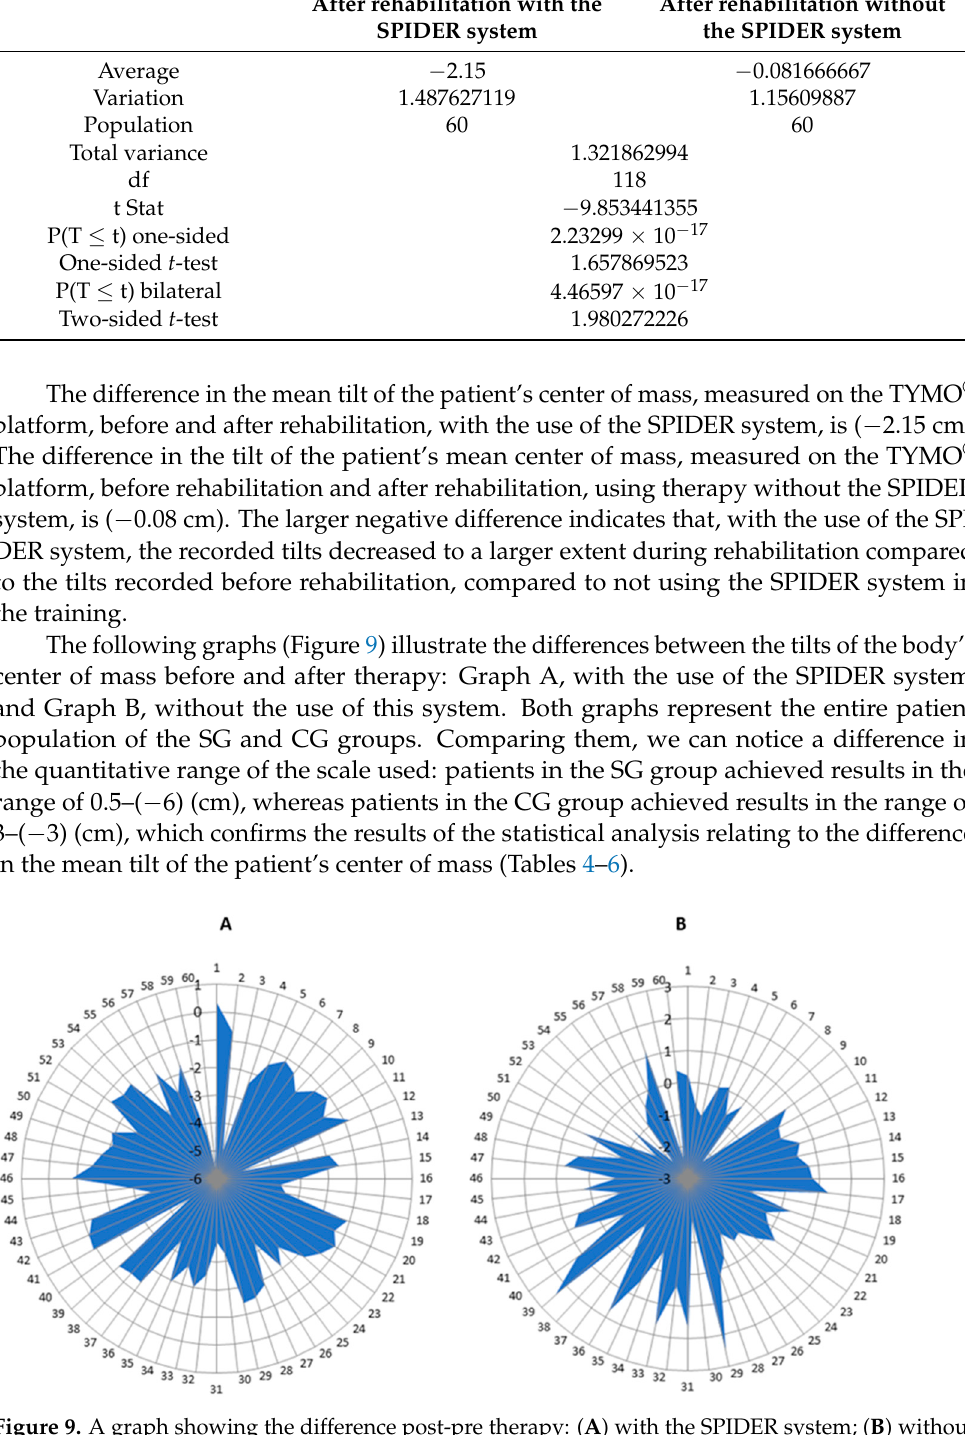
Figure 9. A graph showing the difference post-pre therapy: ( A ) with the SPIDER system; ( B ) without the SPIDER system. 160—number of participants; 2.5–( − 6)—amount of deviation.